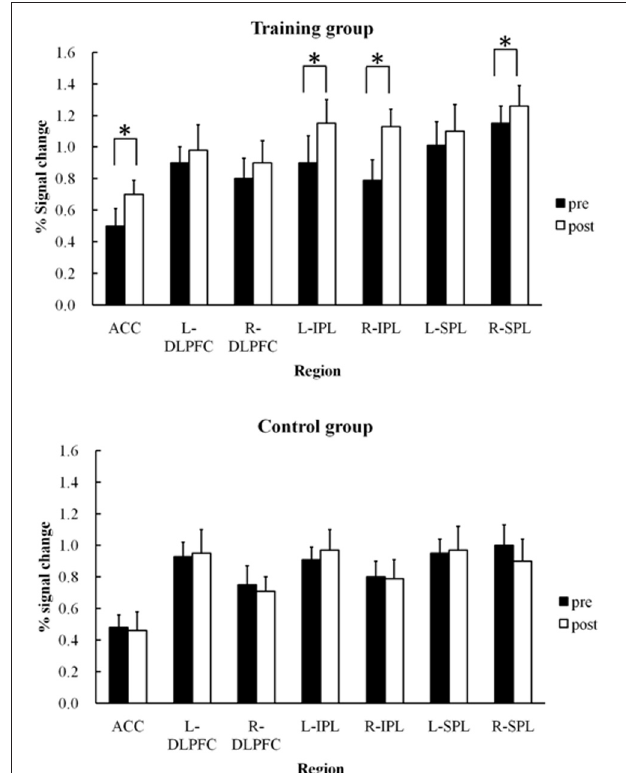
FIGURE 4 | Mean percent signal changes and SDs under training and control groups in each region of interest (ACC, bilateral DLPFC, bilateral IPL, bilateral SPL) during pre- and post-training RST ( ∗ p < 0 .